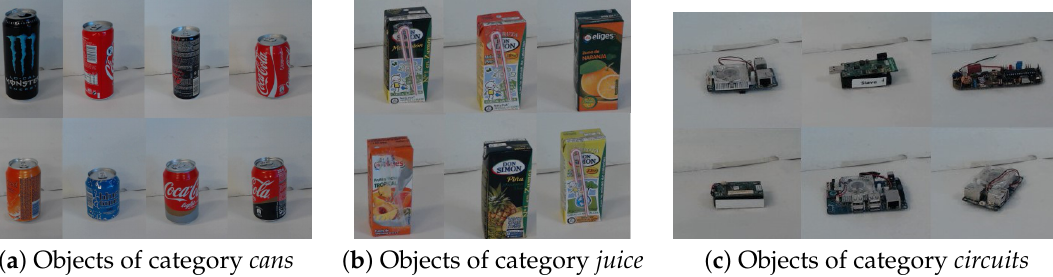
Figure 9. Our test objects were also grouped into categories. We see category examples belonging to cans in ( a ); juice boxes in ( b ) and circuits in ( c ).